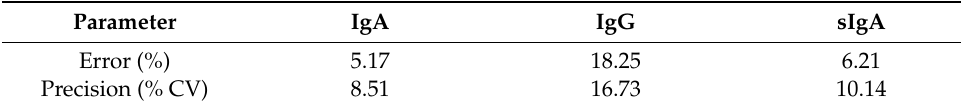
Table 2. SARS-CoV-2 IgA and IgG ELISA method